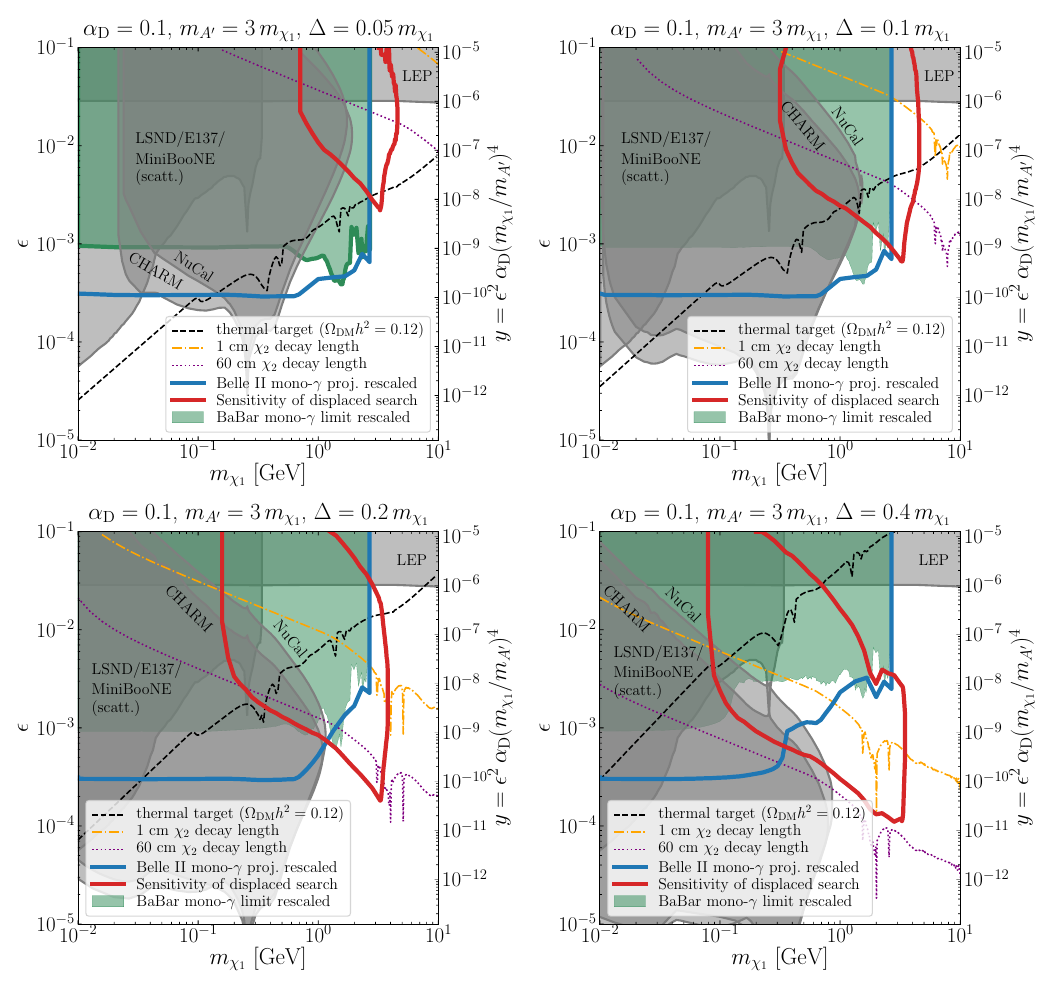
Figure 5 . Sensitivity of Belle II to the parameter space of inelastic DM for an integrated luminosity of 20 fb (cid:0) 1 for m A = 3 m (cid:31) 1 0